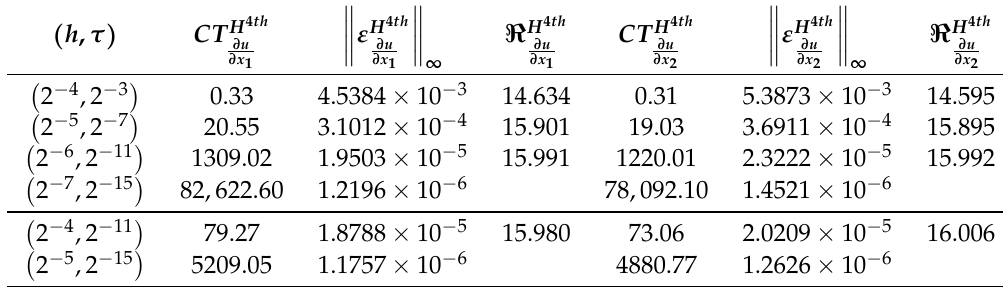
Table 2. CT H 4 th , for i = 1,2 and the convergence orders of v h , τ and z h , τ to their exact ∂ u (cid:13) ∞ ∂ xi respective derivatives for the Example